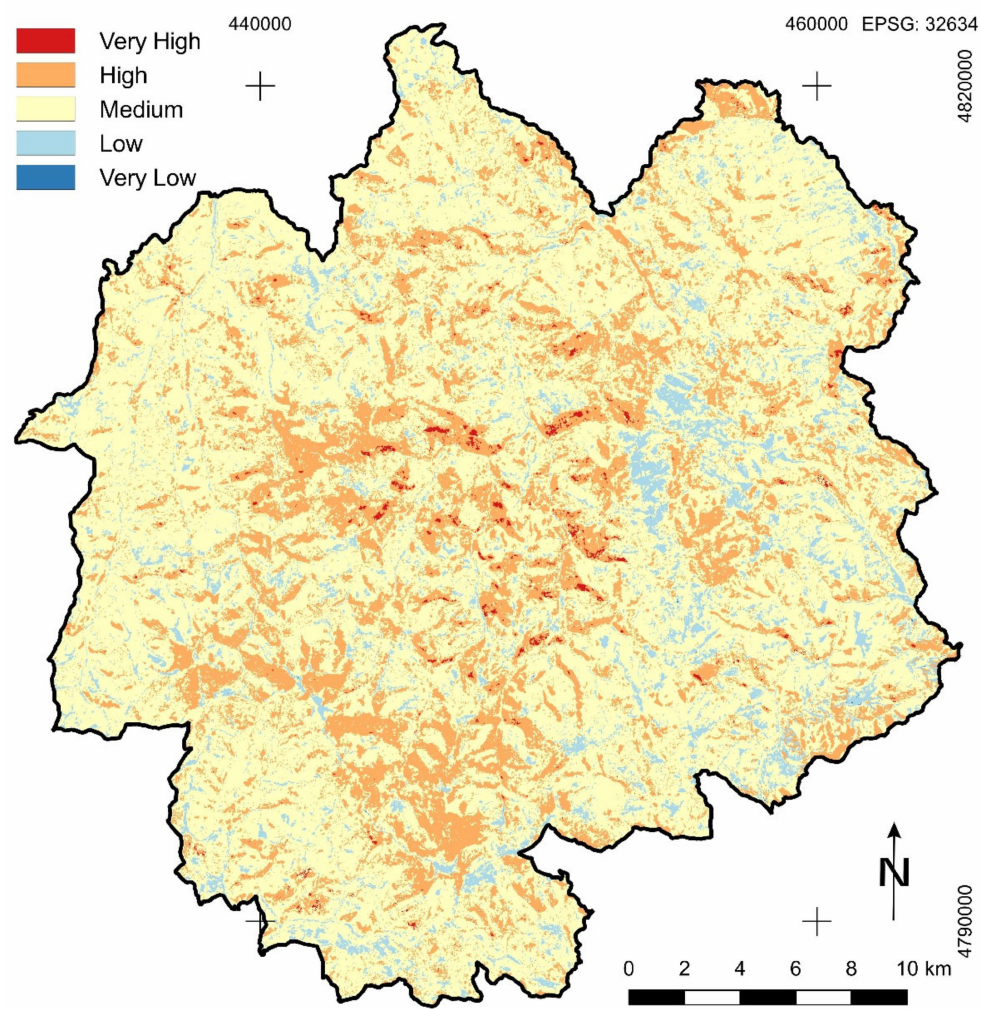
Figure 7. Forest fire susceptibility zones in the Nature Park Golija, according to the fuzzy AHP